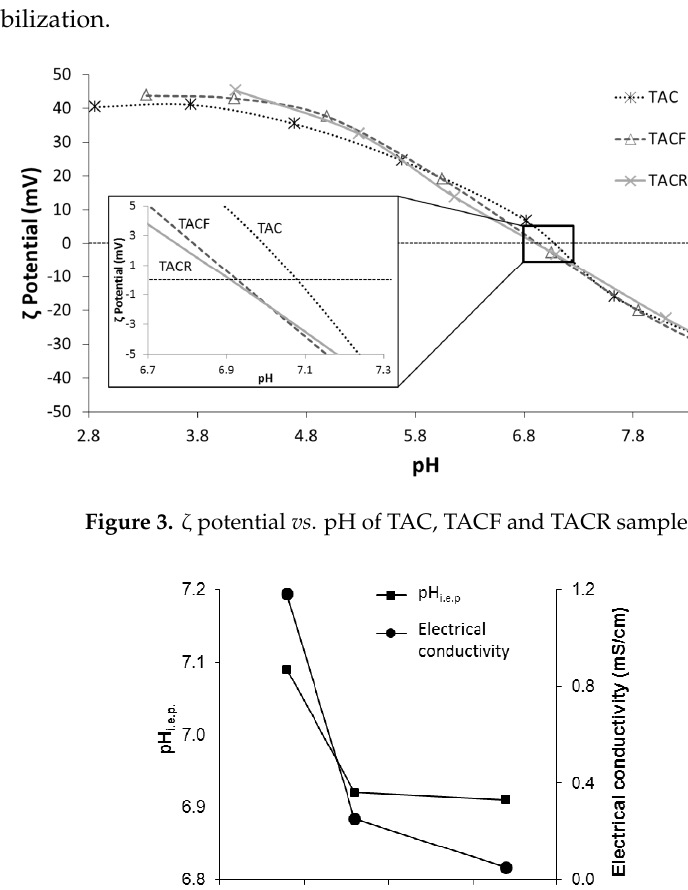
Figure 4. Influence of pH on pH i.e.p. and electrical conductivity.